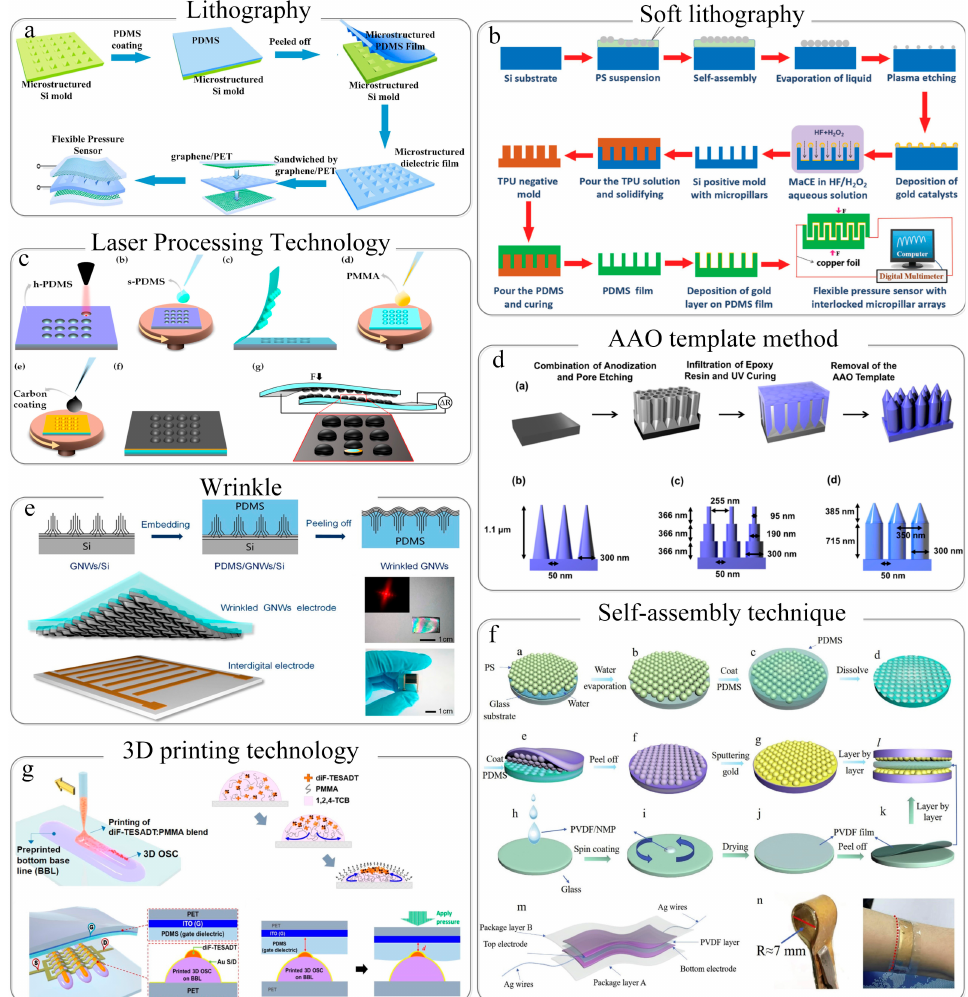
Figure 2. Methods for periodic/quasi-periodic force-sensitive structure to regulate the performance